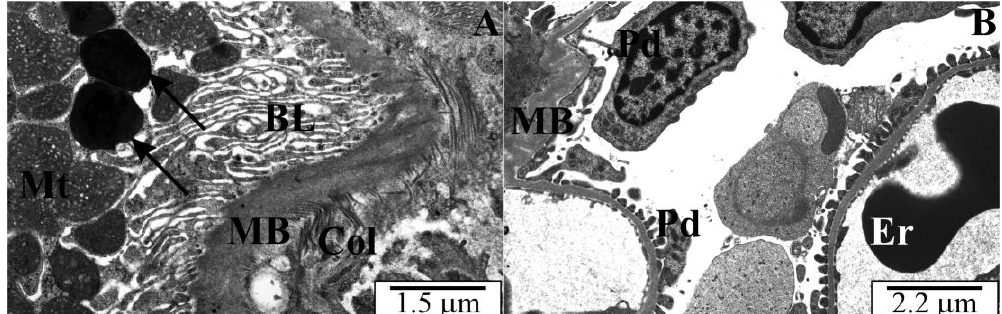
Figure 7. ( A , B ) Electronograms of cross sections through the renal cortex of rats with congenital babesiosis. BL—a basal labyrinth, Col—collagen, Er—erythrocyte, MB—basement membrane, Mt—mitochondria, Pd—podocytes, arrows—lysosomes.